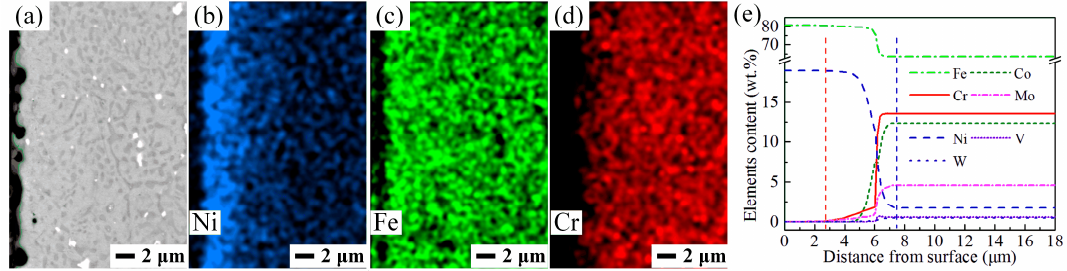
Figure 4. ( a ) Backscattered electron image of the sample coated with 6.0 µ m Fe–Ni film; EDS elements map: ( b ) Ni, ( c ) Fe, and ( d ) Cr; ( e ) simulated alloy element profile after carburizing at 890 °C for 569 min.